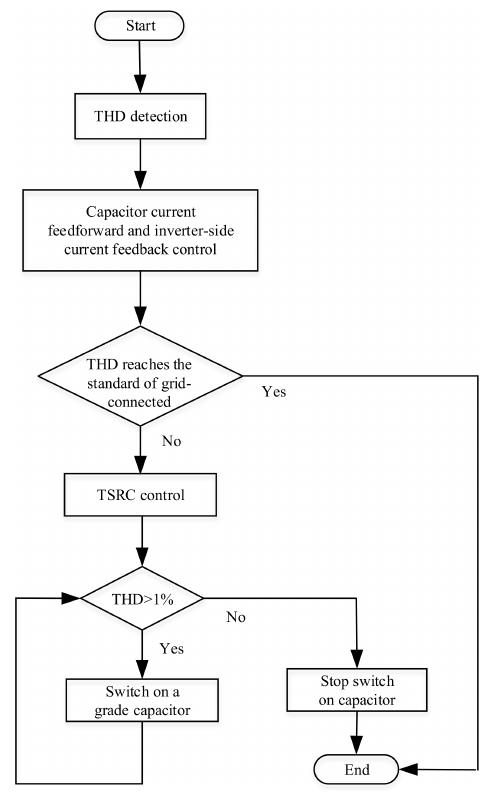
Figure 11. THD control flow